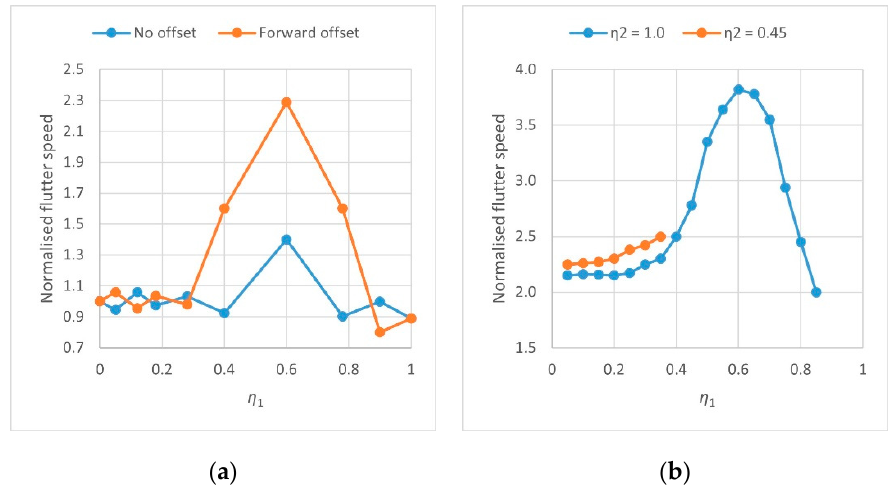
Figure 37. Normalised flutter speed: ( a ) for engine placement along the span for two values of chordwise offset; ( b ) in four-engine configuration with one engine fixed ( η 2) and the other moving ( η 1).